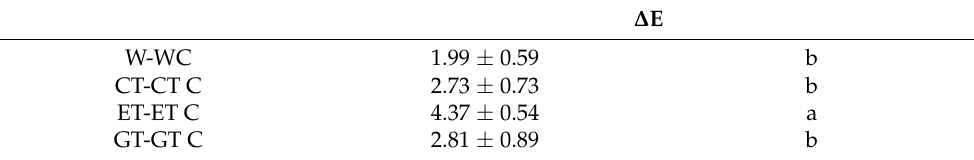
Table 4. Effect of C on ∆ E calculated between samples treated with C and related